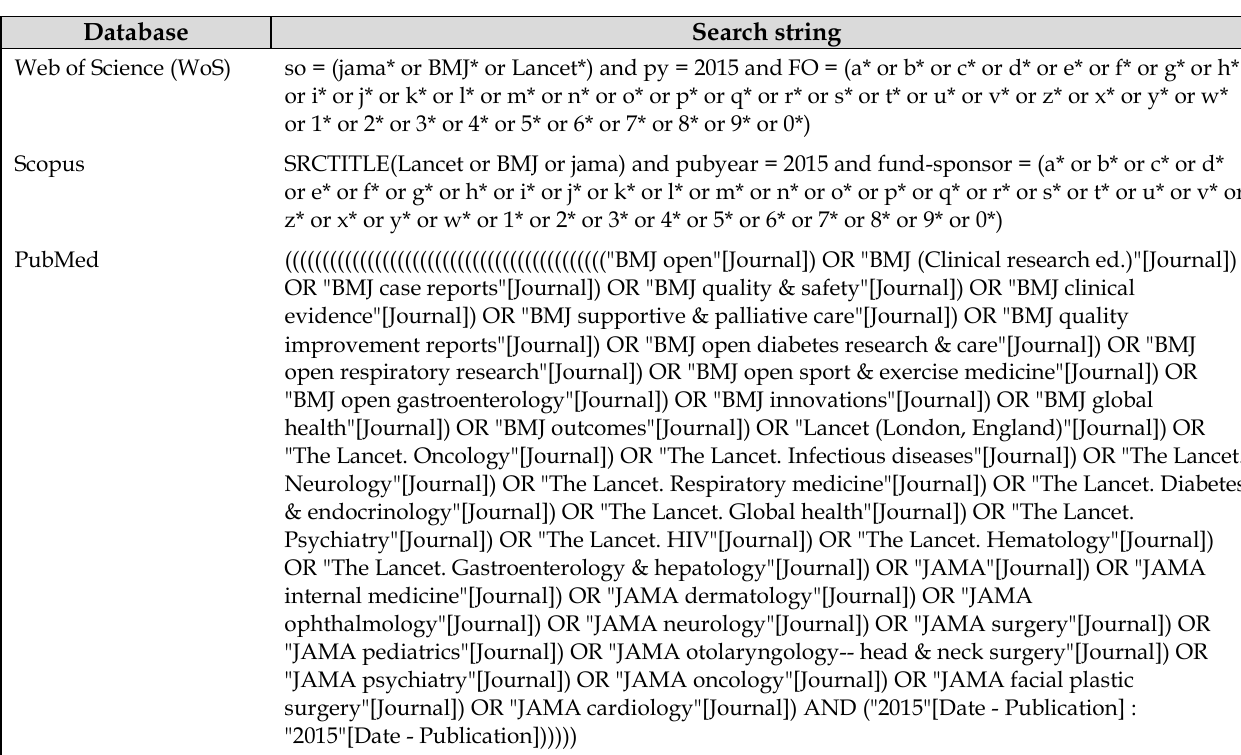
Table 1 Search strings used to retrieve articles with funding information Database Search